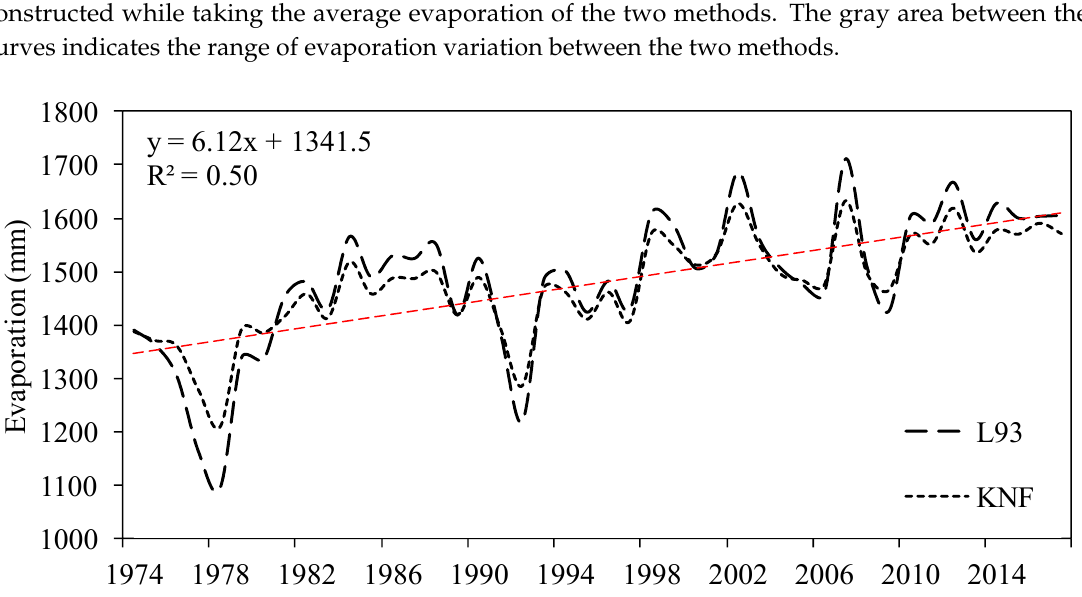
Figure 7. Total annual evaporation estimated by the best performing methods (KNF: Kohler et al. (1955) and L93: Linacre (1993)) based on the historical series and the trend line (dashed line).